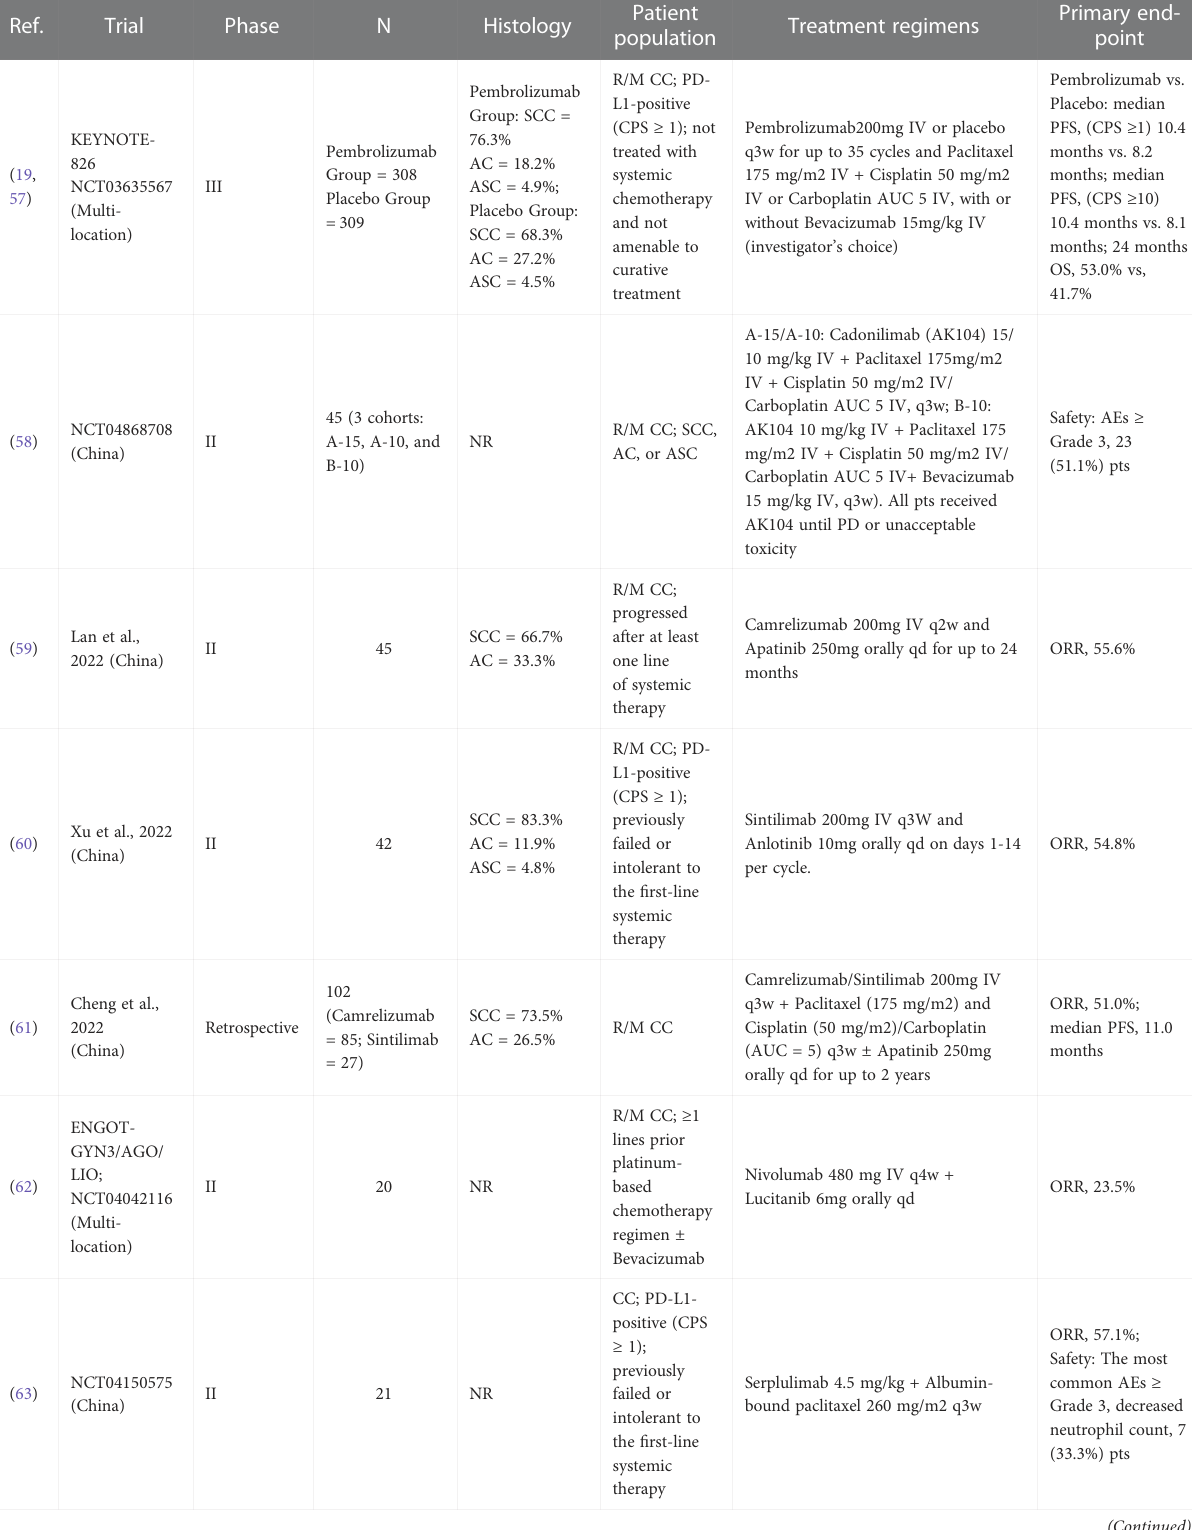
TABLE 3 Published data on combination therapy with immune checkpoint drugs for recurrent/metastatic cervical cancer.